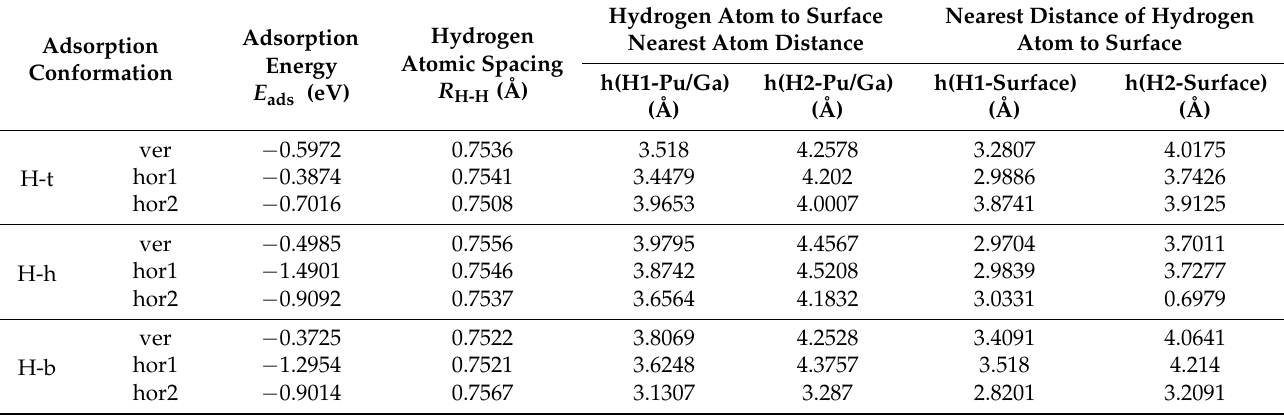
Table 1. Structural parameters and energy data of the adsorption configuration of H 2 on the surface of the plutonium–gallium system. (H1 and H2 represent two atoms of the hydrogen